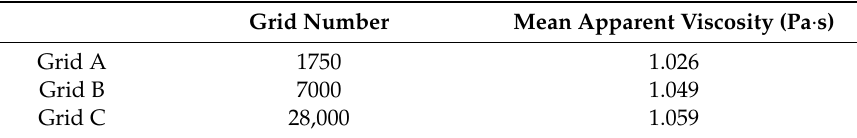
Table 2. Mesh dependency study of the tapered